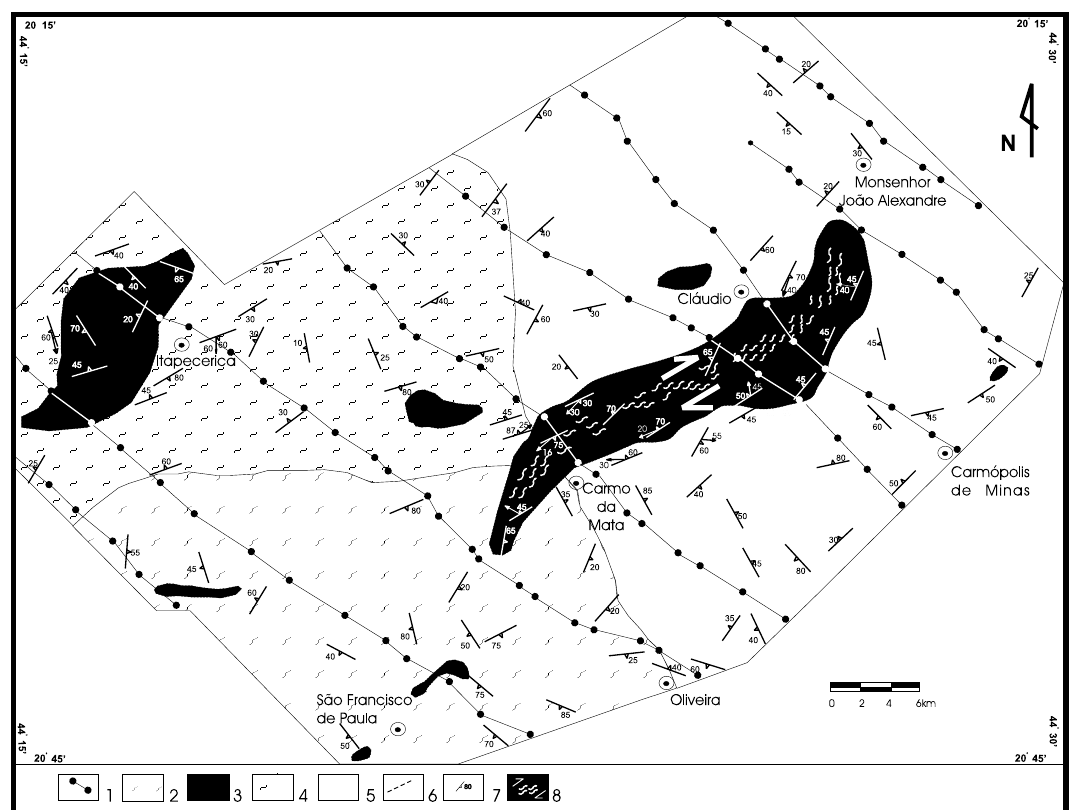
Fig. 2–Geologicmapofthestudyarea(modifiedfromOliveira1999), showingthedifferentlithodemicunits: 1)FissureMaficUnit; 2) Supracrustal Unit; 3) Candeias Gneissic Unit; 4) Itapecerica Gneissic Unit; 5) Cláudio Gneissic Unit; 6) Inferred Contact; 7) Foliation; 8) Cláudio Shear Zone, and 9) Key Outcrops: A – Fernão Dias road; B – Corumbá dimension stone quarry; C – Kinawa dimension stone quarry; D – Morro da antena; E – Vista Bela farm; F – Carmo da Mata dimension stones quarry; G – Marilan dimension stones quarry; H – Lila dimension stones quarry; I – Alemão dimension stones quarry; J – Oliveira dimension stones